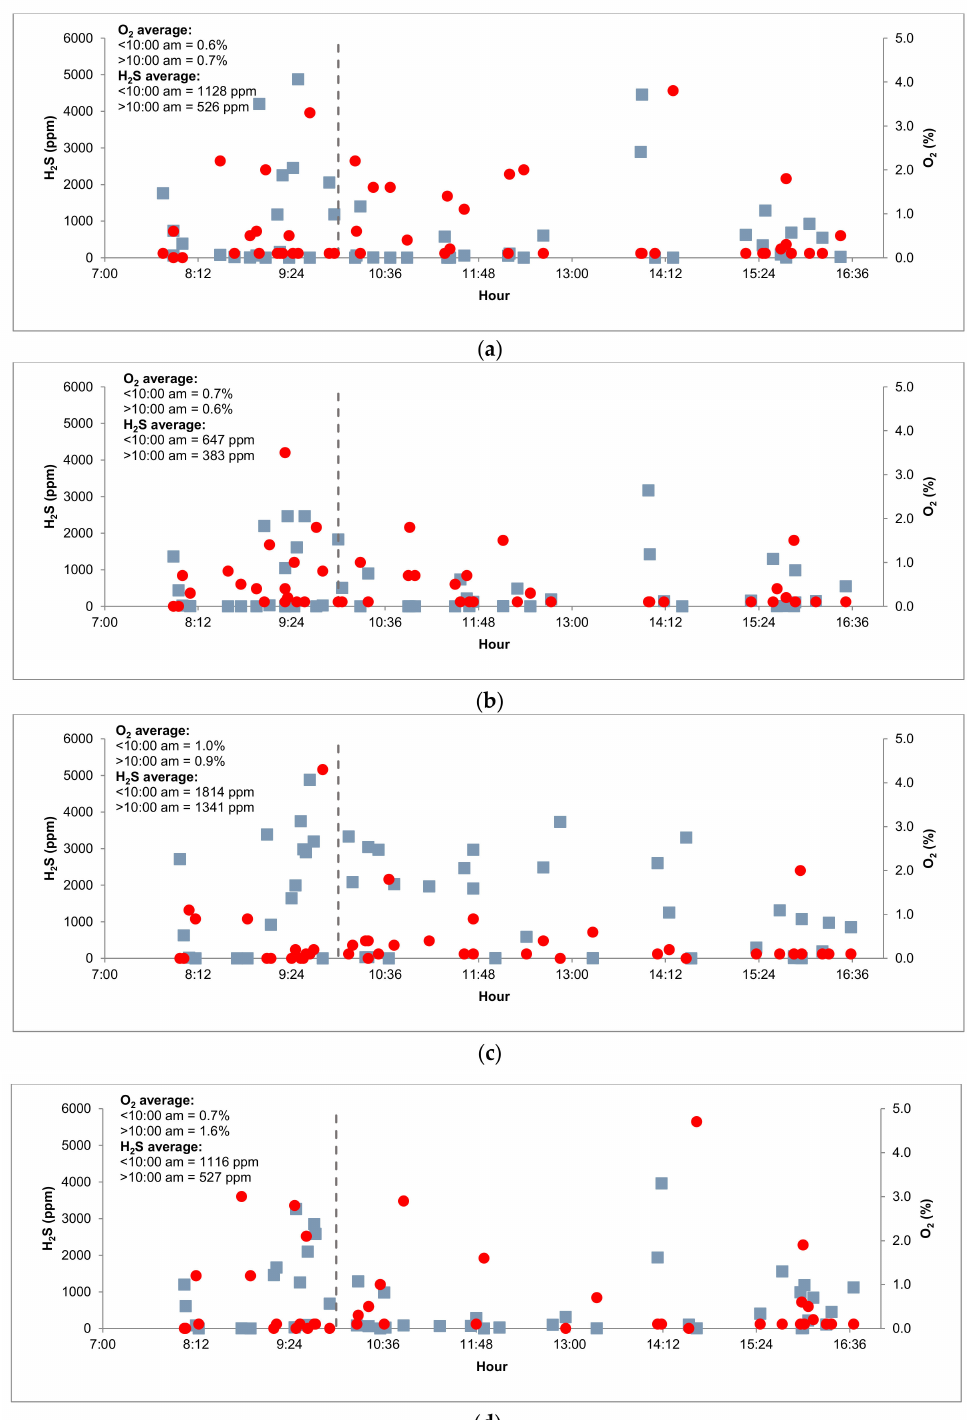
Figure 4. Evolution of H 2 S and O 2 daily concentrations per reactor: ( a ) R1; ( b ) R2; ( c ) R3; ( d ) R3. Note: Vertical grey lines denote measurements done before and after 10:00 am; blue squares denote H 2 S concentrations; red circles denote O 2